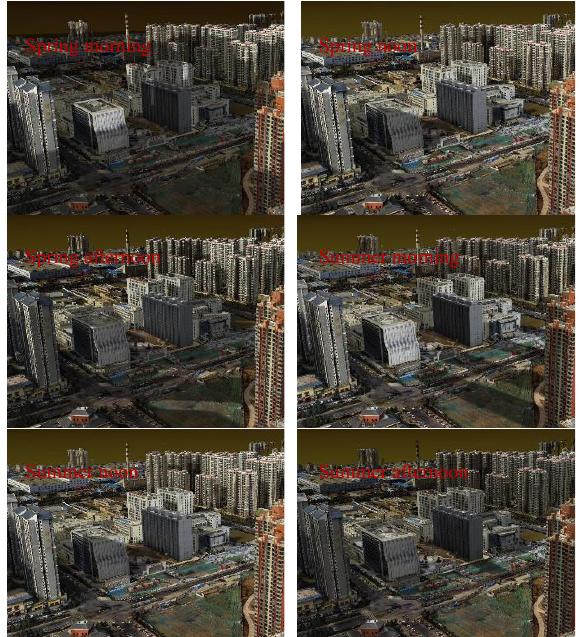
Figure 7. Visual